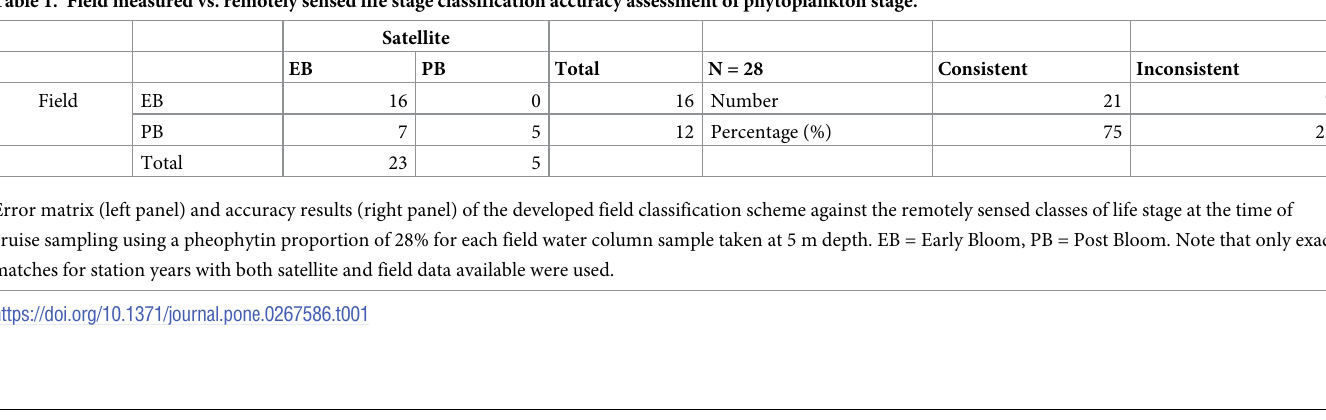
Table 1. Field measured vs. remotely sensed life stage classification accuracy assessment of phytoplankton stage.